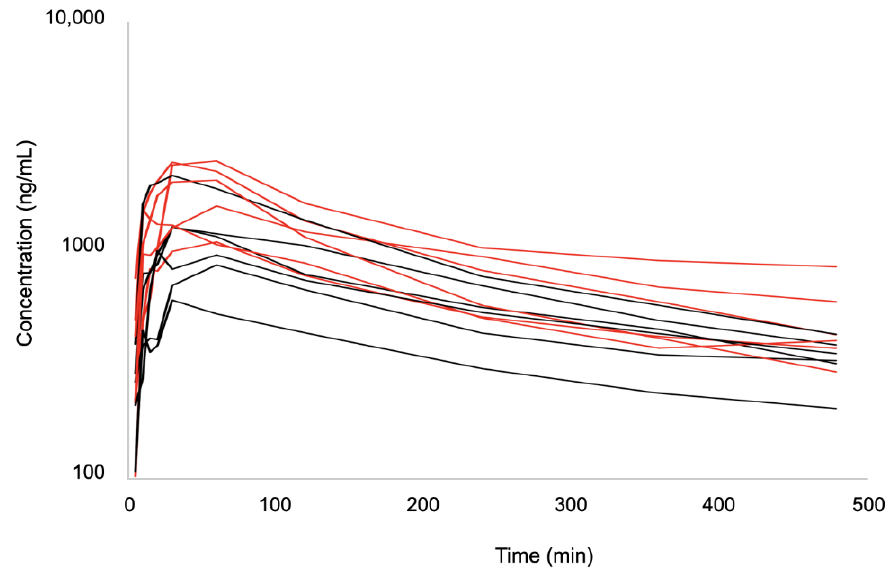
Figure 2. Spaghetti plot of the individual plasma concentrations of bupivacaine after injection of 2 mg/kg (BUPI-2; black) and 2.5 mg/kg (BUPI-2.5; red) by bilateral ultrasound-guided transversus abdominis plane block in twelve female cats (n = 6/group).